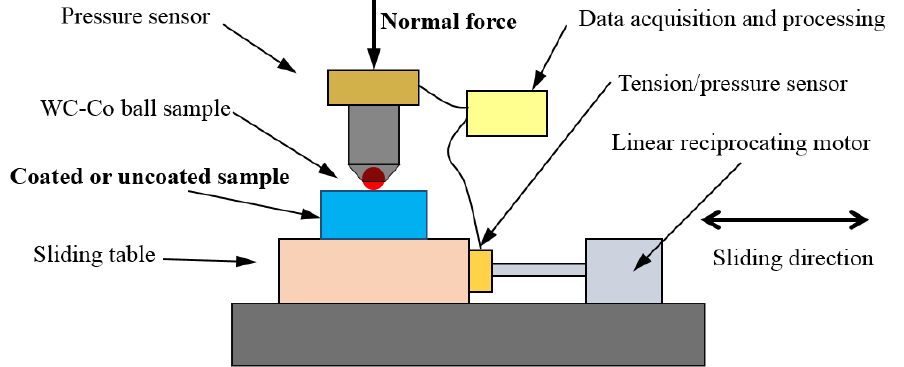
Figure 2. Schematic of the reciprocating sliding test machine. Table 5. Test parameters.